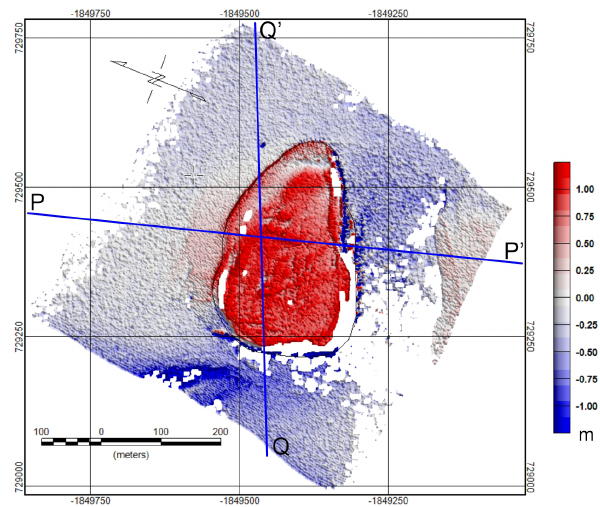
Figure 6. Change in surface elevation between 22 and 30 Decem- ber 2019 lidar surveys. Blue lines locate section profiles shown in Fig.